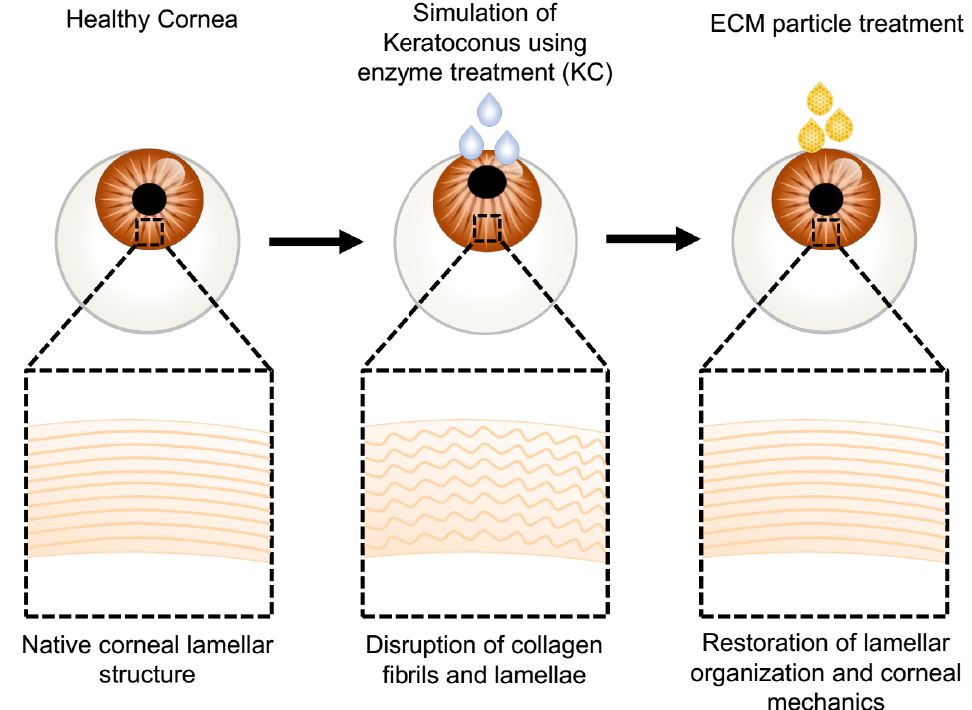
Figure 1. Schematic of treatment procedure to produce the ex vivo ectatic models and subsequent tissue-derived biological particles (TDP) treatments. Fresh rabbit eye globes were treated with chondroitinase to create an ex vivo corneal ectatic keratoconus model (KC) that simulates the ultrastructural damage observed in keratoconus corneas. The modeled KC corneas were cultured in TDP-suspended medium. Optical, mechanical, and ultrastructural characterization demonstrated the restoration of the ultrastructure and mechanical integrity of the KC corneas following TDP treatment.